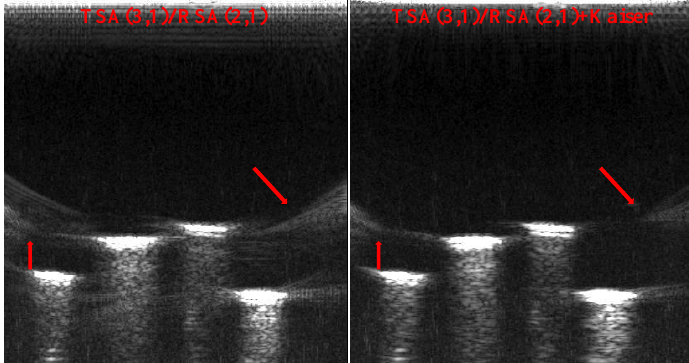
Figure 13. Imaging results of different CMUT sparse array configurations (